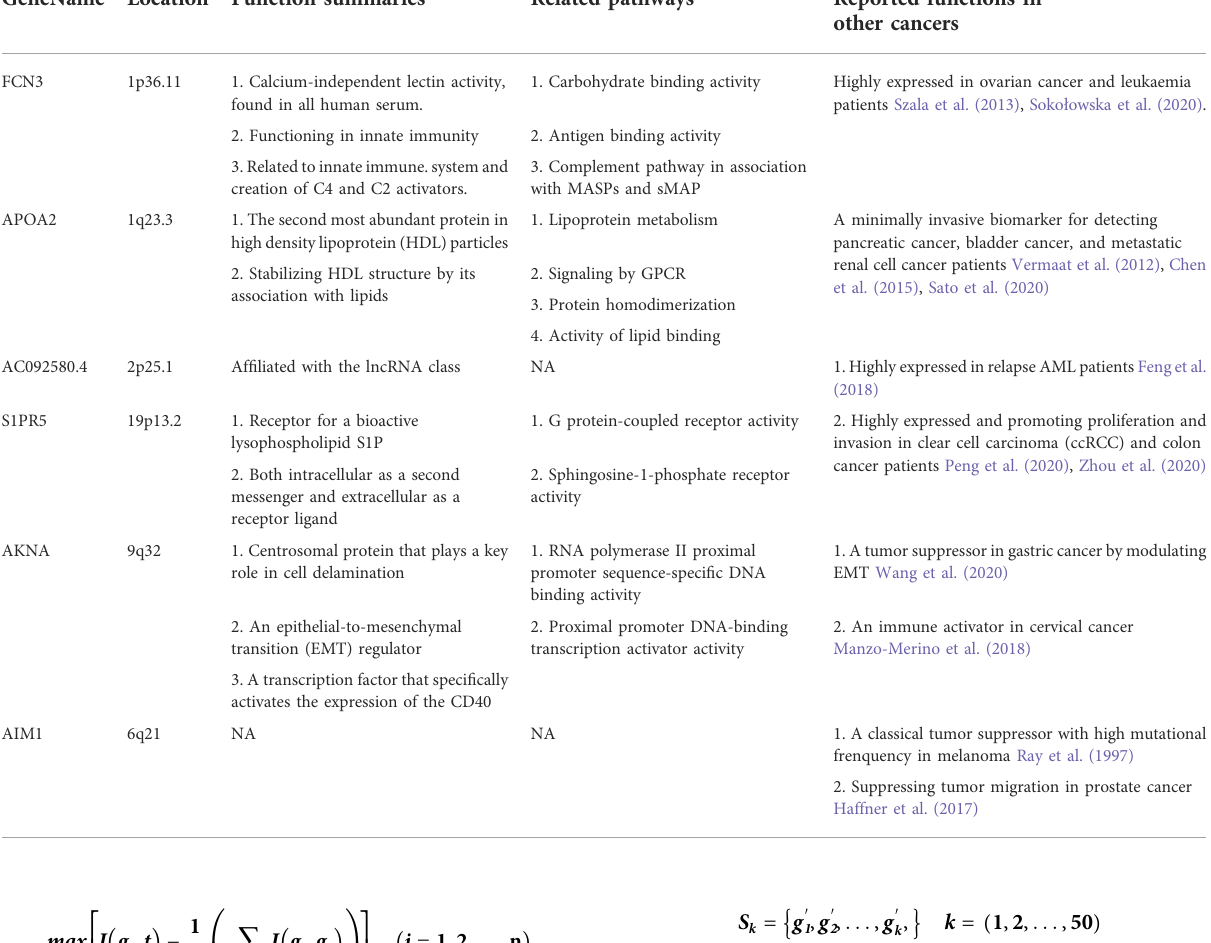
TABLE 5 Summary for markers reported in other cancers. GeneName Location Function